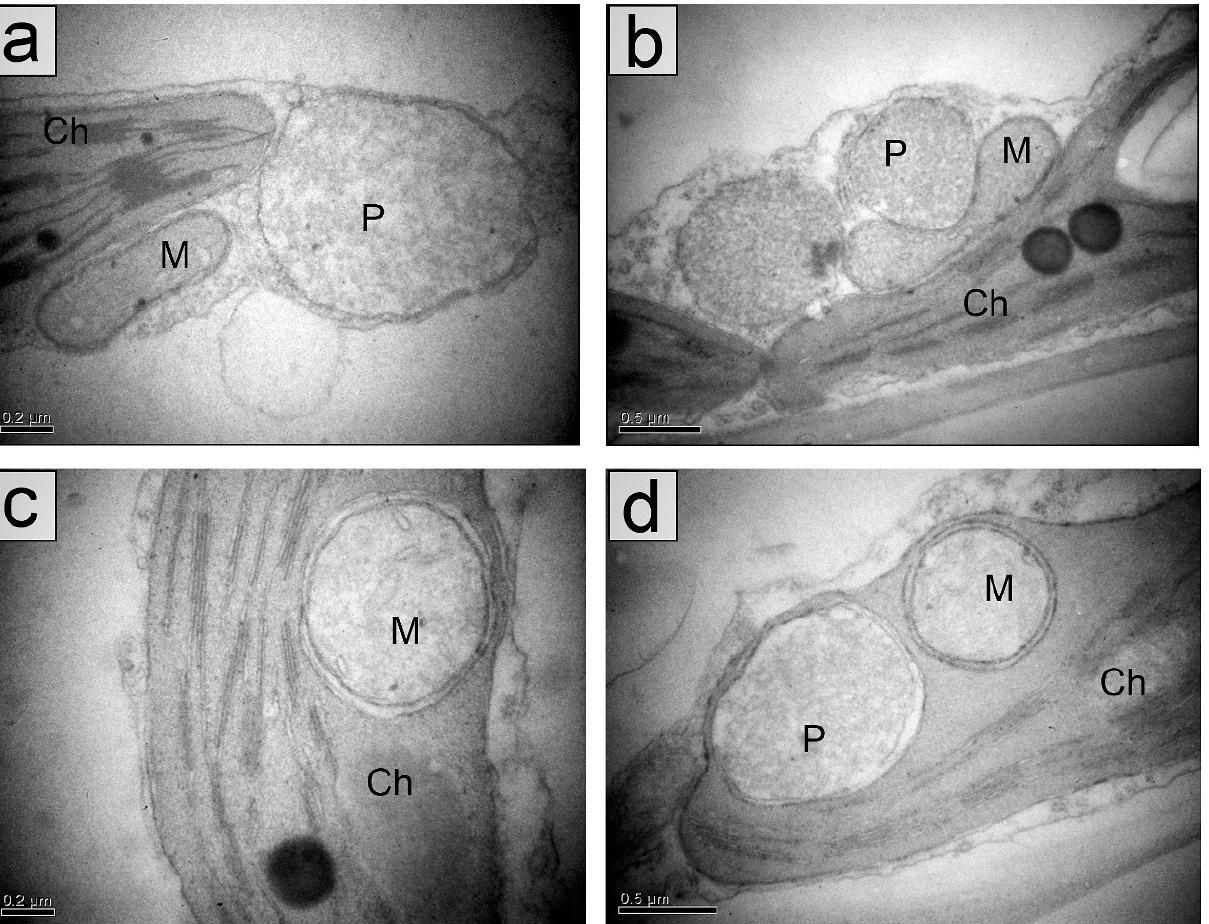
Figure 3. Fragments of palisade parenchyma cells of mature leaves of Hydrocharis morsus-ranae in